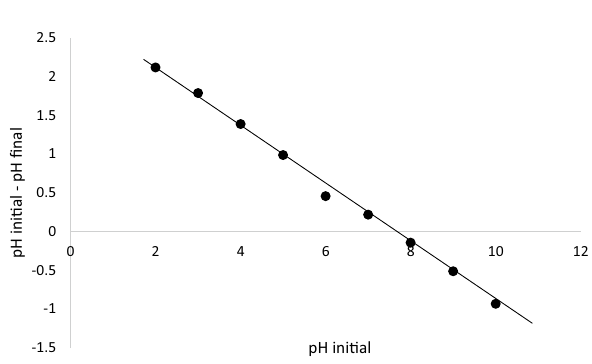
Fig. 3 pH point of zero charge (pHpzc)